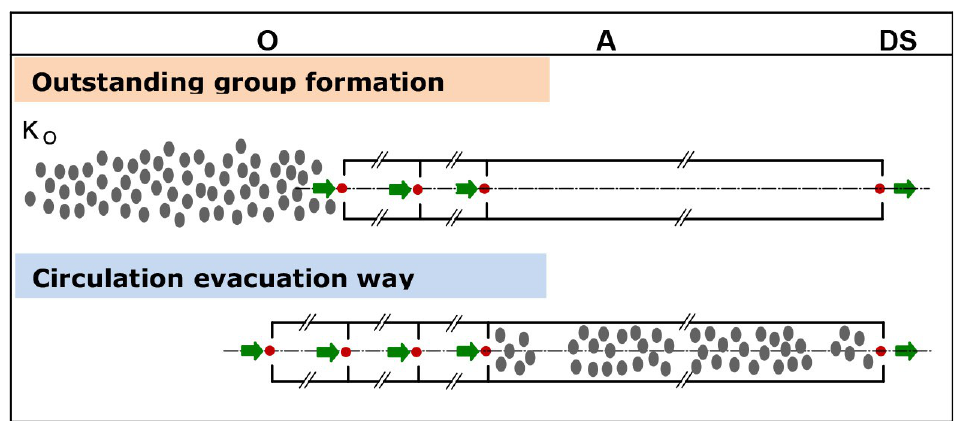
Figure 6. Groups forming in the evacuation route due to the speed of movement